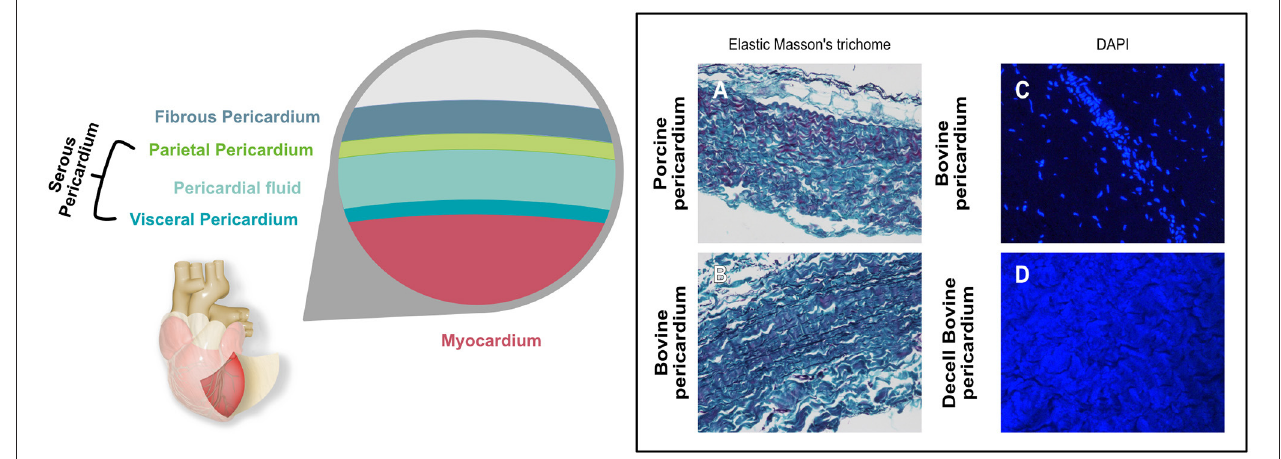
FIGURE 1 | Graphical representation showing the different layers of the pericardial sac. Histological micrographs (A,B) with Elastic Masson’s trichrome stain shows the different components contained in the pericardium and how they differ between bovine and porcine. Keratin and muscle fibers are shown in red, collagen in blue or green, cytoplasm in light red or pink and cell nuclei are dark brown to black and elastic fibers in black. (C,D) show the DAPI stain of bovine pericardium before (C) and after decellularization (D) . Nuclei that show as bright blue dots in (C) are absent in (D) , where blue background results from autofluorescence. a thin layer of loose connective tissue (25). The mesothelial